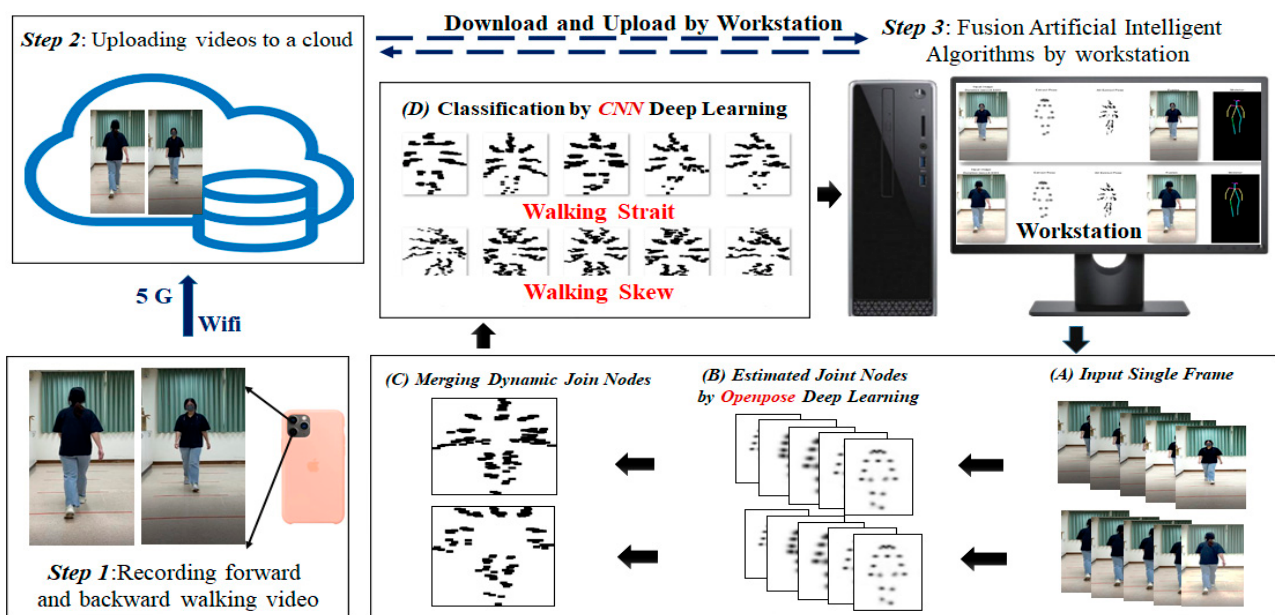
Figure 1. Flow of research.